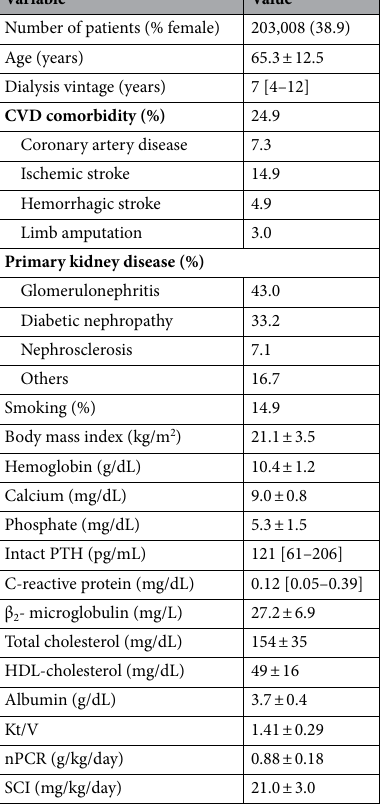
Table 1. Baseline clinicodemographic characteristics and laboratory values in 203,008 hemodialysis patients. CVD cardiovascular disease, HDL high-density lipoprotein, nPCR normalized protein catabolic rate, PTH parathyroid hormone, SCI simplified creatinine